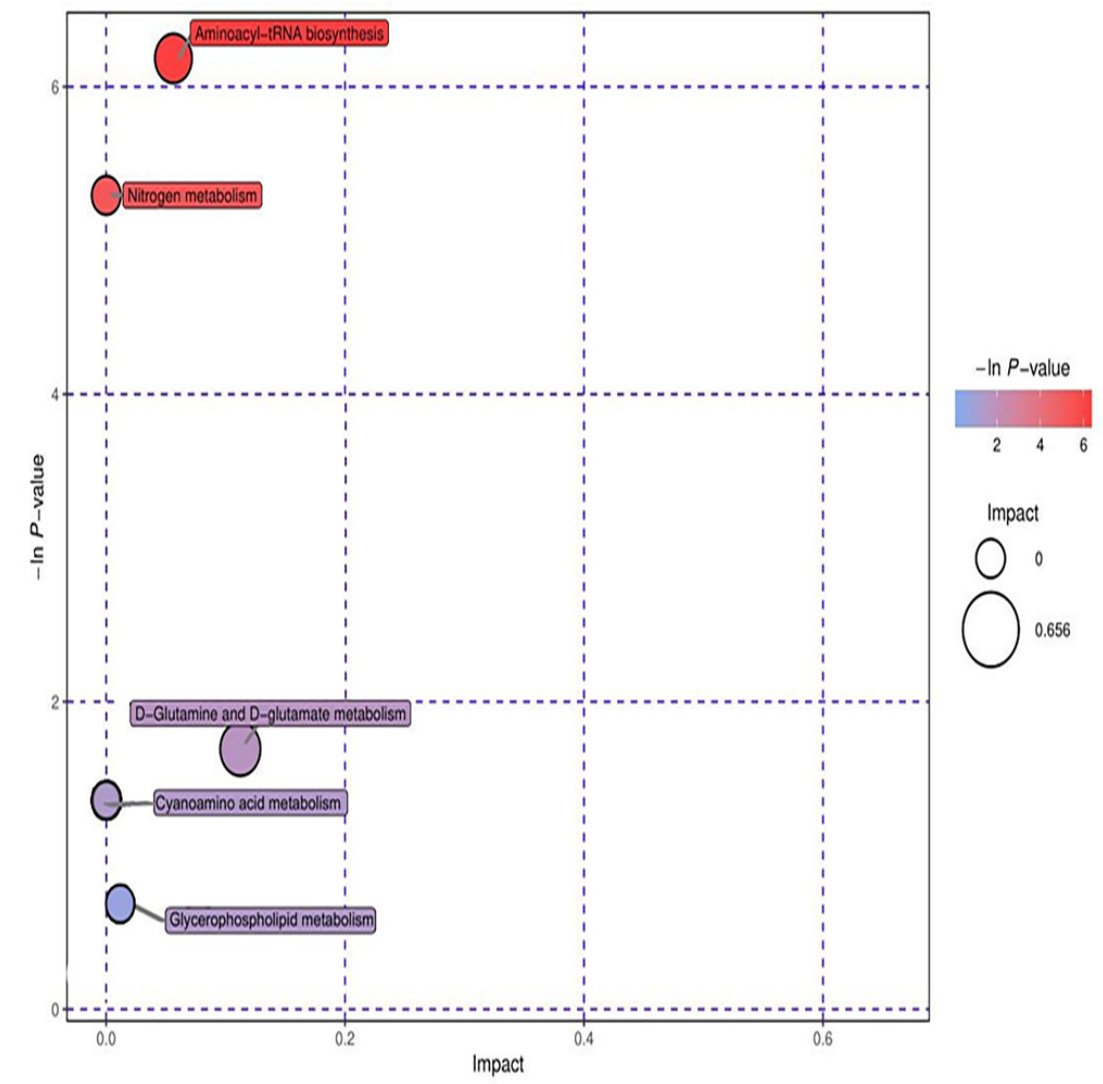
Figure 13. Topological analysis of positive ions. The ordinate of metabolic topological analysis was -ln(P), and the value of P represents significance. The lower the value of P and the higher the value of -lnP, the more significant the enrichment of metabolites in this pathway. The abscissa impact was the path influence value. The greater the influence value of the pathway, the more likely the metabolites of the query were consistent with the metabolites of the